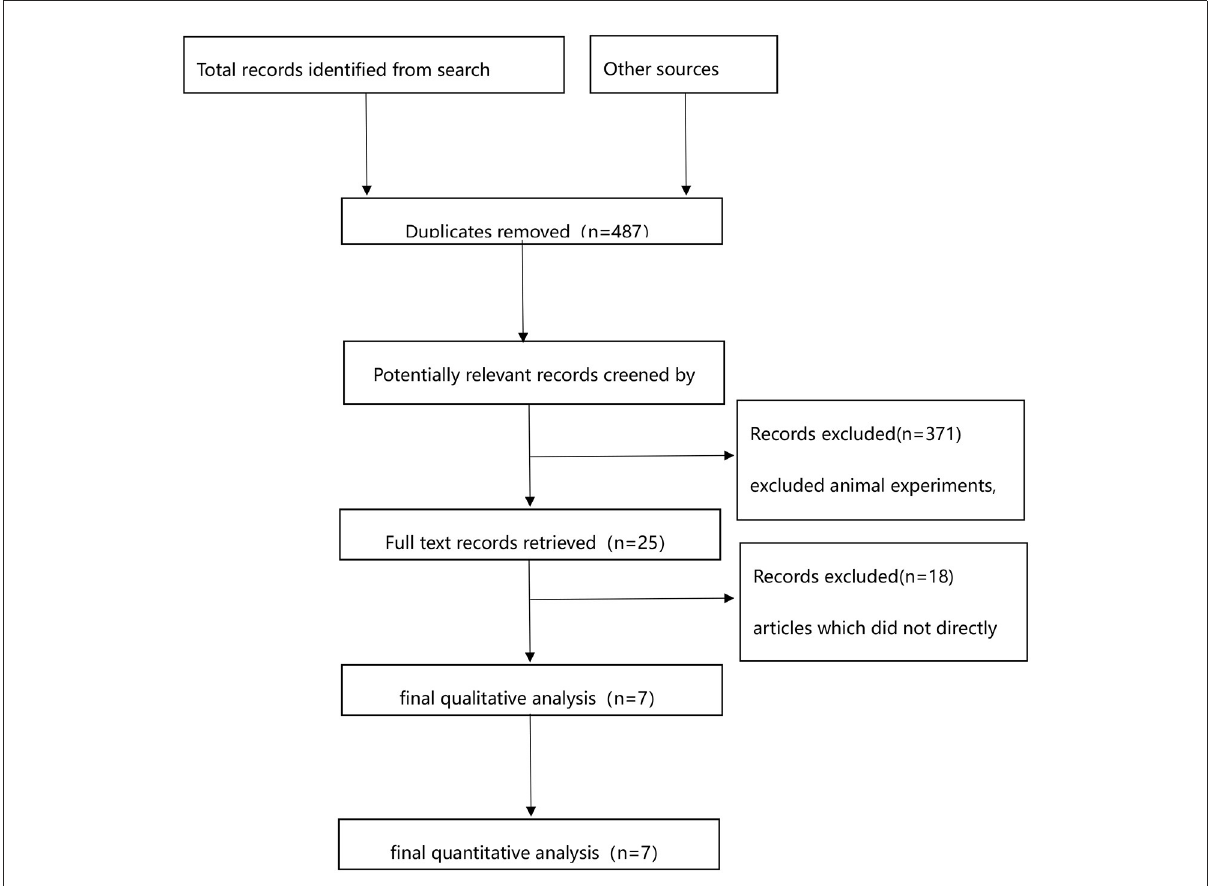
FIGURE1 PRISMA flow